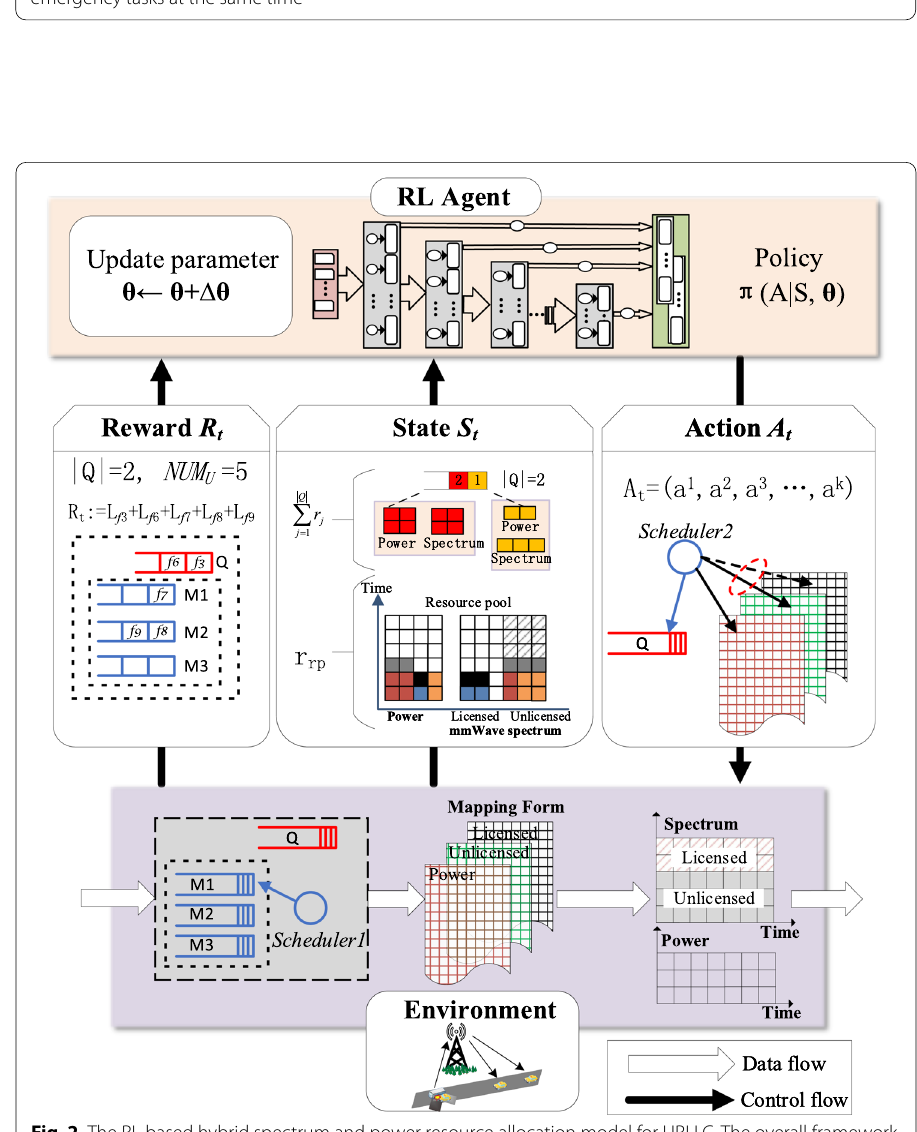
Fig. 2 The RL-based hybrid spectrum and power resource allocation model for URLLC. The overall framework of figure is an RL framework. There are control procedures (control flow) and data processing procedures (data flow) in this framework. The bottom of figure is the data flow in the external environment. Each step of the data flow is specifically completed according to the RL agent at the top of figure. The external environment processes data information into Status and Rewards and feeds back to the Agent. The Agent gets the Action after learning with the DNN and returns it to the